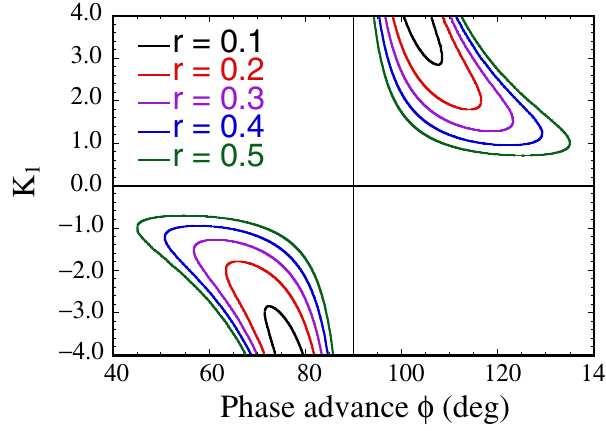
is displayed as a func- 1